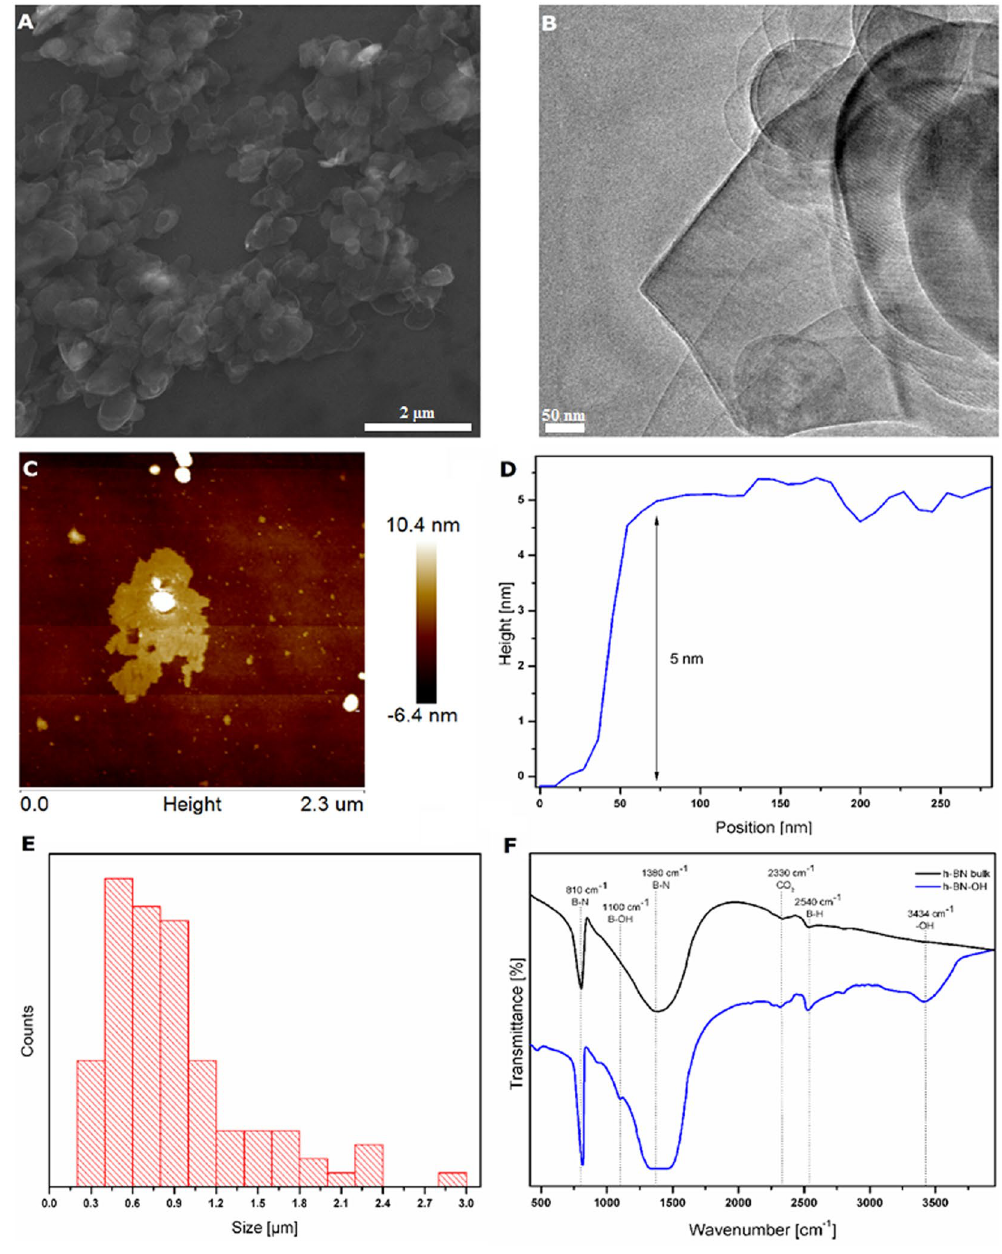
Figure 1. Scanning ( A ) and transmission ( B ) electron microscope images of h-BN-OH, ( C ) AFM of h-BN-OH, ( D ) height profile of h-BN-OH, ( E ) size distribution of h-BN-OH and ( F ) FT-IR spectrum of h-BN-OH and bulk